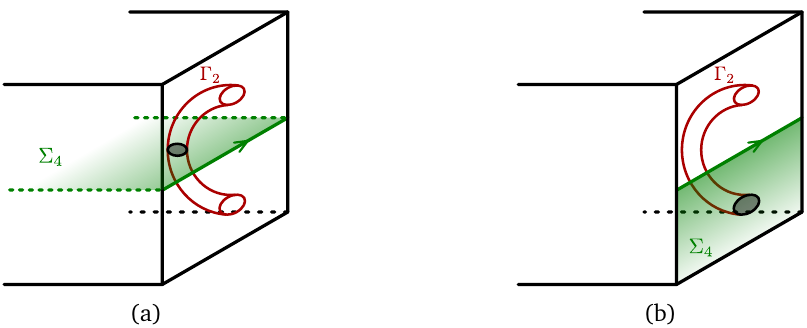
Figure 3: A non-invertible symmetry defect placed at the boundary of AdS . a) The auxiliary surface is extended through the bulk. b) The auxiliary surface is pushed to the